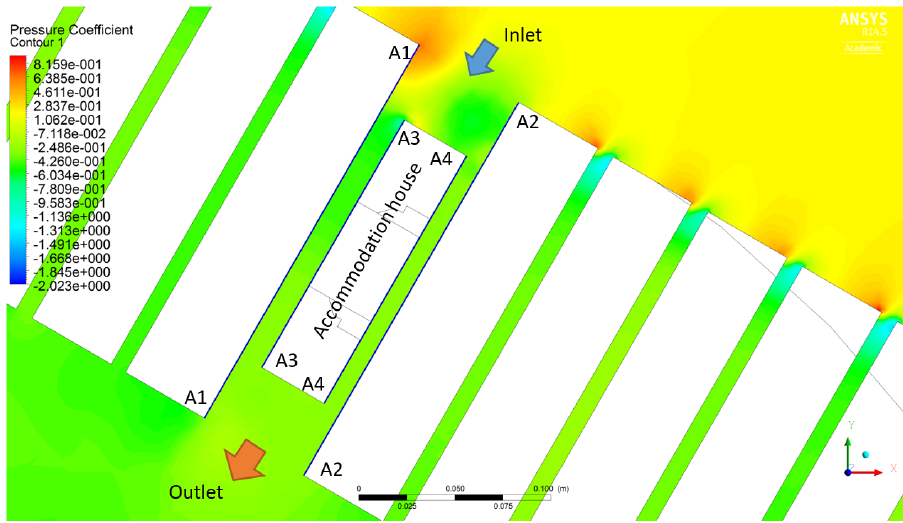
Figure 22. Pressure near the accommodation house.